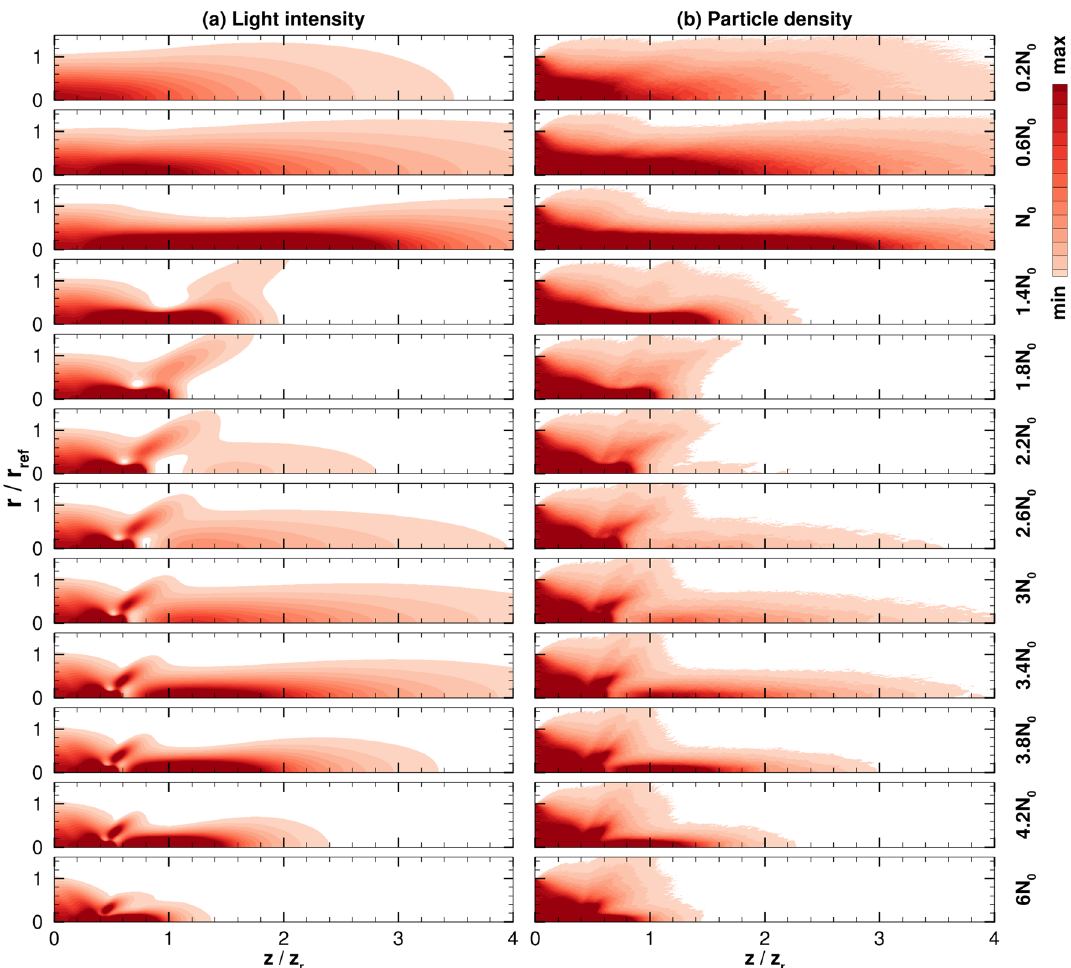
Figure 6. Normalized ( a ) light intensity and ( b ) particle density over a range of injection particle densities 3 13 relative to N 0 = 5.0 × 10 m − , which is the critical density that results in a single mode waveguide, i.e., V = 2.405 . The min and max values are 0.1 and 1,